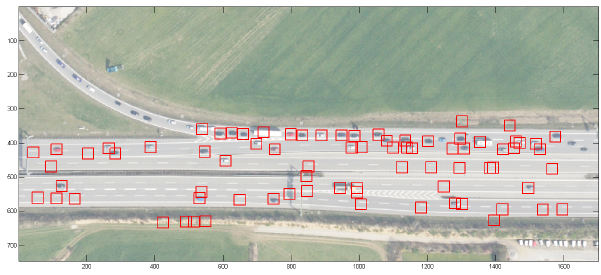
Figure 6: Classification result without motion